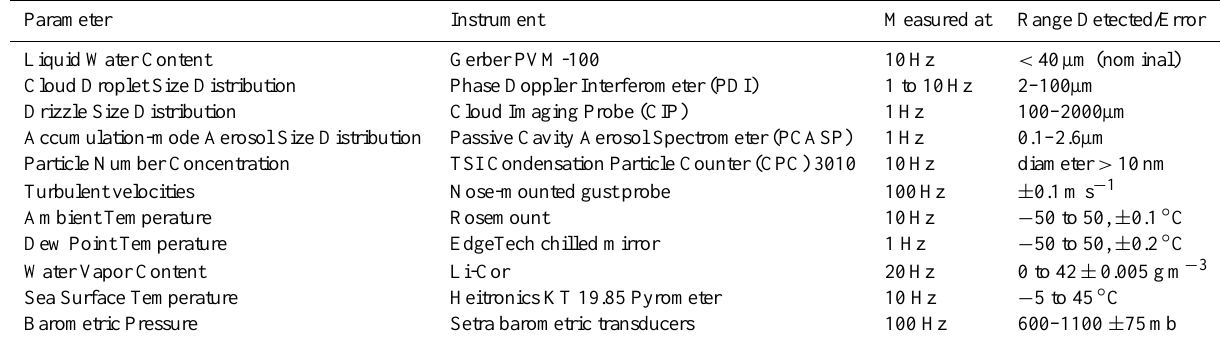
Table 2. Aerosol and cloud instrument payload on Twin Otter during field campaigns. Abbreviated list; only instruments referenced in this article are listed.